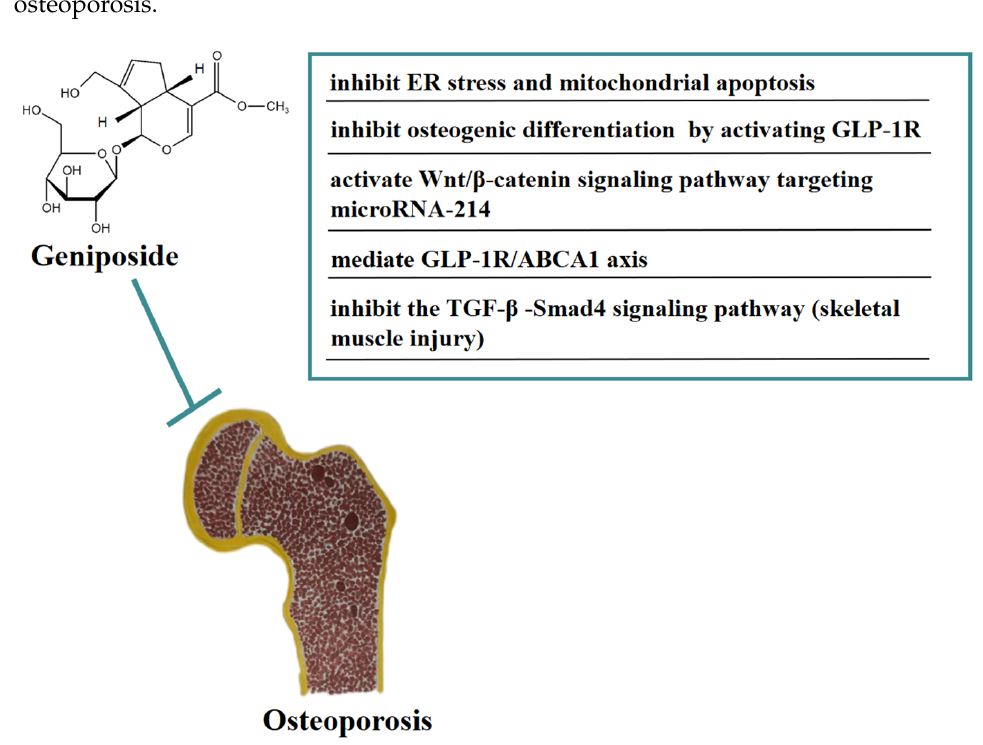
Figure 3. A summary of mechanisms of geniposide on